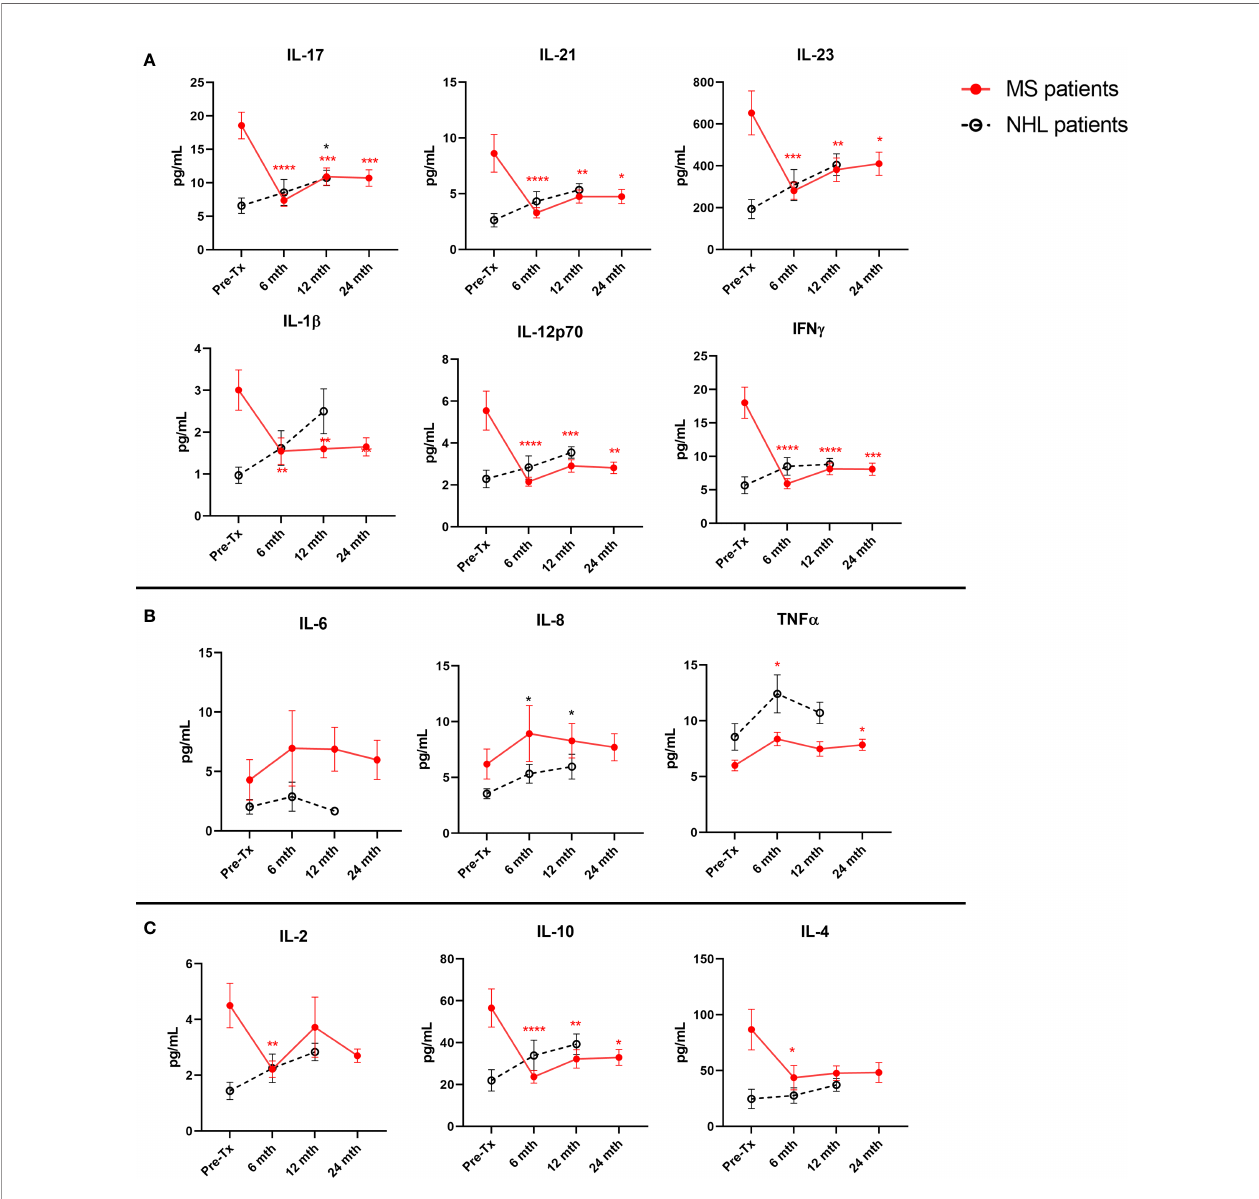
FIGURE 2 | Long-term post-AHSCT changes to plasma cytokine levels in MS and NHL patients. Cytokine concentrations were quanti fi ed at pre-AHSCT (pre-Tx), 6 months (mth), 12 months, and 24 months post-AHSCT. (A) Suppression of T cell associated proin fl ammatory cytokines (Th17: IL-17, IL-21, IL-23, and IL-1 b ; Th1 IL- 12p70 and IFN g ) are sustained up to 24 months post-AHSCT in MS patients only. (B) In contrast, the initial increase in other proin fl ammatory cytokines (IL-8, IL-6 and TNF a ) were not maintained at later timepoints. (C) Plasma concentration of anti-in fl ammatory cytokines (IL-10 and IL-2) at speci fi ed timepoints in patients undergoing AHSCT. MS cohort sample size is n=22, and NHL cohort sample size is n=9. Sample sizes per timepoint are as follows: 1) 6 months: MS n=21; NHL n=9, 2) 12 months: MS n=21; NHL n=9, and 3) 24 months: MS n=21. Analysis was performed using a one-way repeated measures ANOVA with Holm-Sidak post- hoc . * p < 0.05; ** p < 0.01; *** p < 0.001; **** p